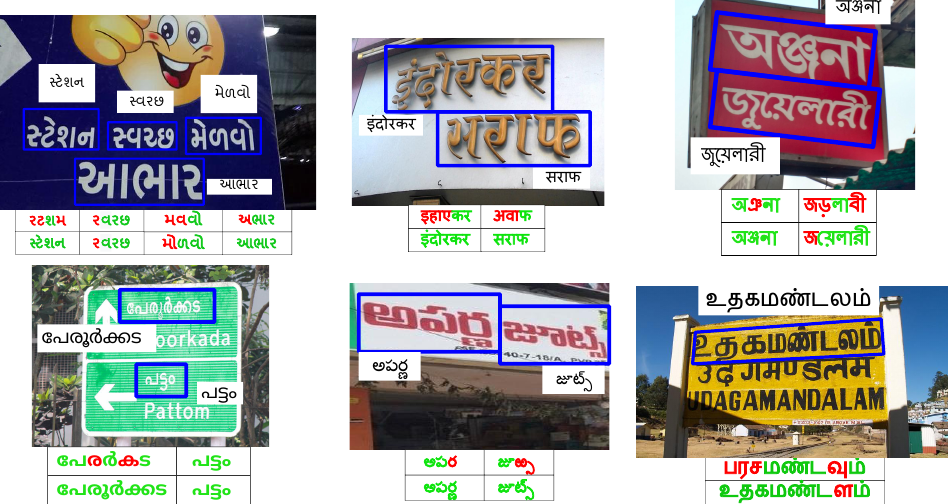
Figure 1. Clockwise from top-left: Top: Annotated Scene-text images, Below each image: Baselines’ predictions (row-1) and Transfer Learning models’ predictions (row-2), from Gujarati, Hindi, Bangla, Tamil, Telugu and Malayalam. Green, red, and “_” represent correct predictions, errors, and missing characters, respectively.